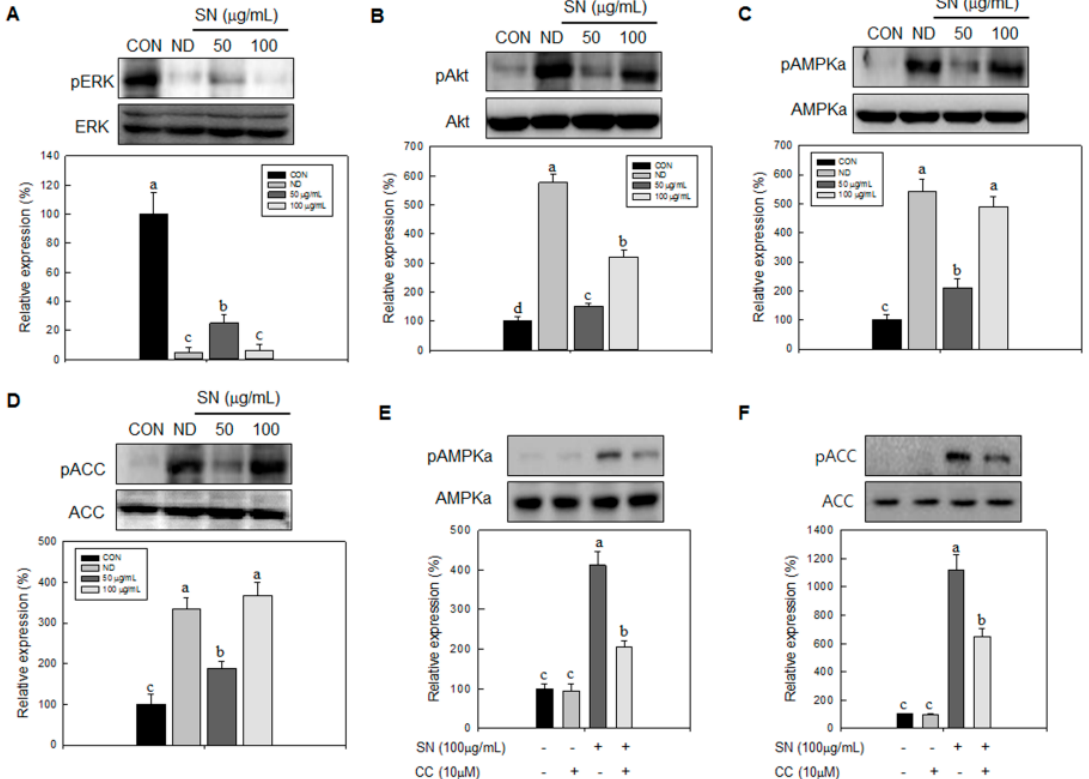
Figure 7. Effects of SN on signaling pathways. 3T3-L1 preadipocyte was treated with and without SN during adipocyte differentiation. ( A – C ) Expression levels of signaling factors were analyzed in lysates harvested after 1 or 2 h of differentiation, measured by immunoblotting, and quantified using the ImageJ software; ( D – F ) An inhibitor (Compound C , 10 µM) of the AMPK signaling pathway was added to measure the dependent effect of SN (100 µg/mL) on AMPK α signaling. CON: control, SN: seapolynol, ND: non-differentiated 3T3-L1, CC: Compound C . Data are presented as means ± SD from three replicate experiments. Means not designated by a common superscript are significantly different ( p < 0.05).